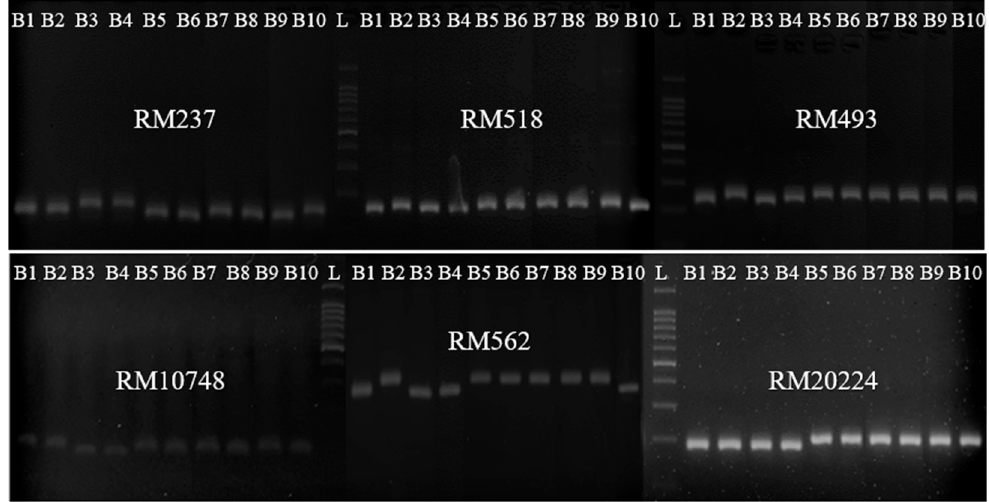
Figure 2. PCR products of simple sequence repeat (SSR) markers RM 237, RM 518, RM 493, RM 10748, RM 562, and RM 20224 (L: ladder 100 bp).